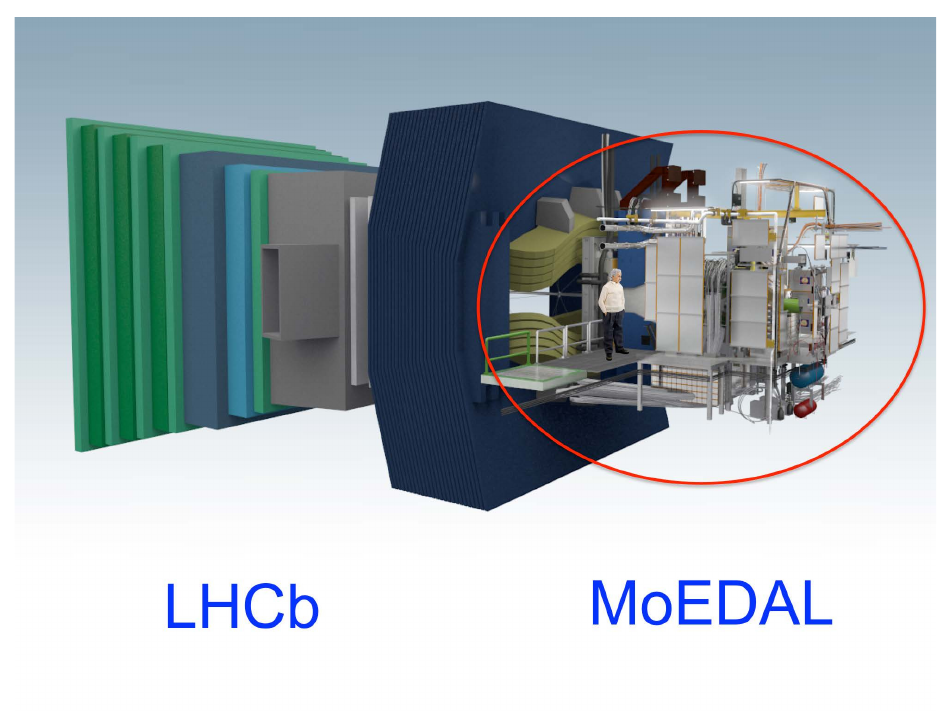
Figure 1. A schematic view of the MoEDAL detector and its deployment at